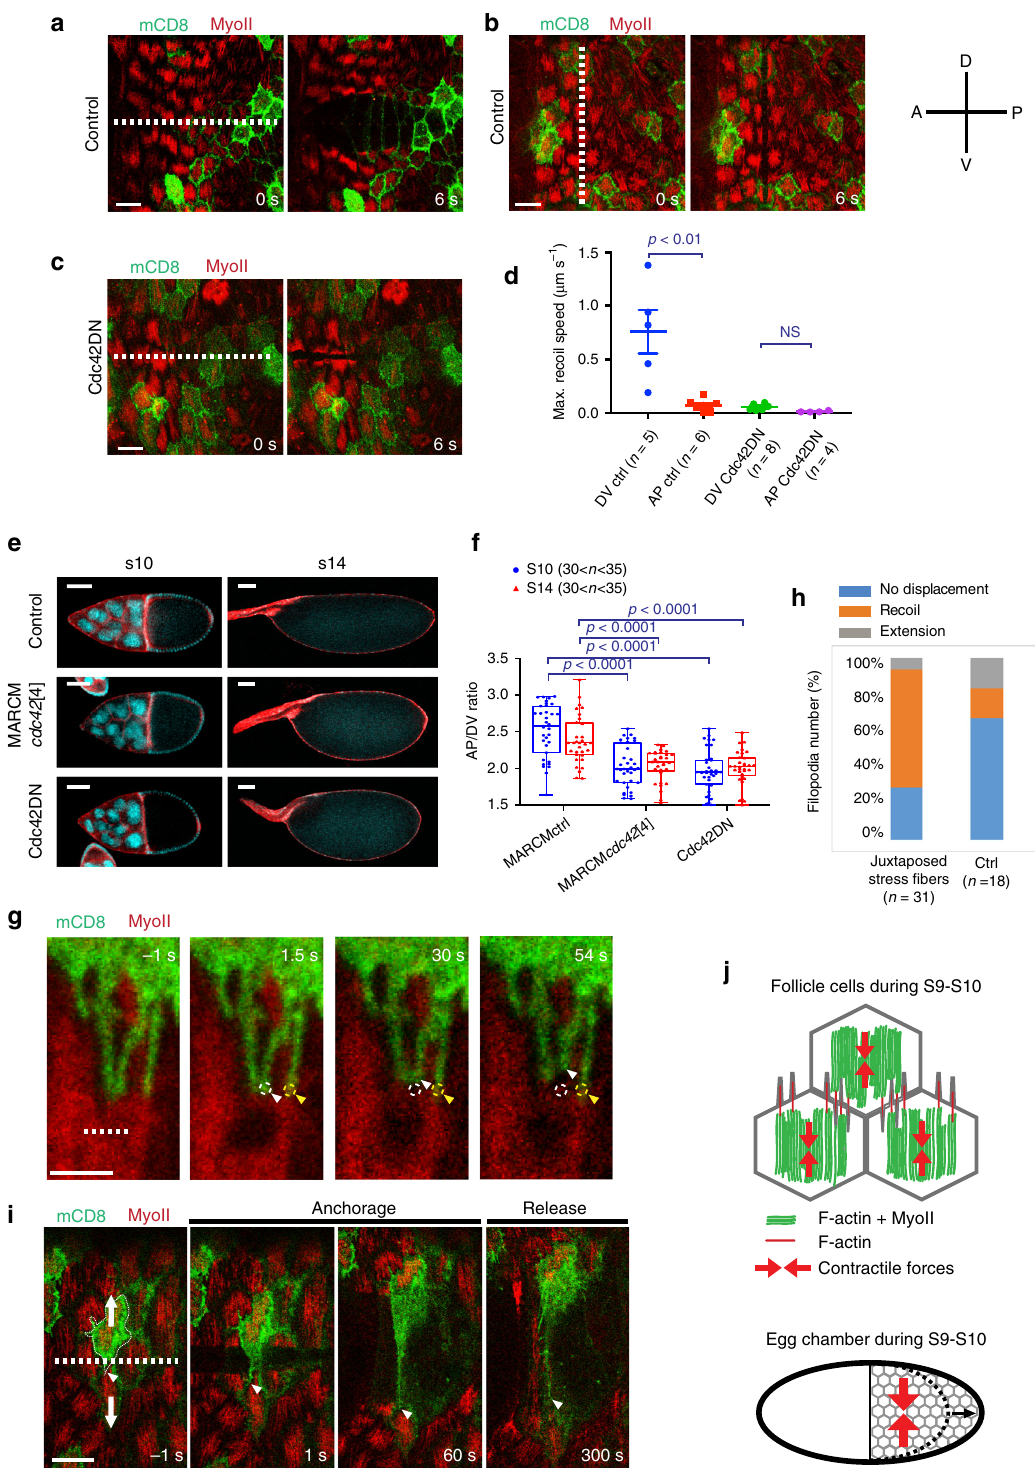
antibodies, usually overnight at 4 °C. The anti-WASP antibody (P5E1, 1:200 dilution; validation information available at https://dshb.biology.uiowa.edu/P5E1- Wasp), anti-Ena antibody (5G2, 1:200 dilution; validation information available at https://dshb.biology.uiowa.edu/5G2-anti-enabled), anti-Dlg (4F3, 1:200